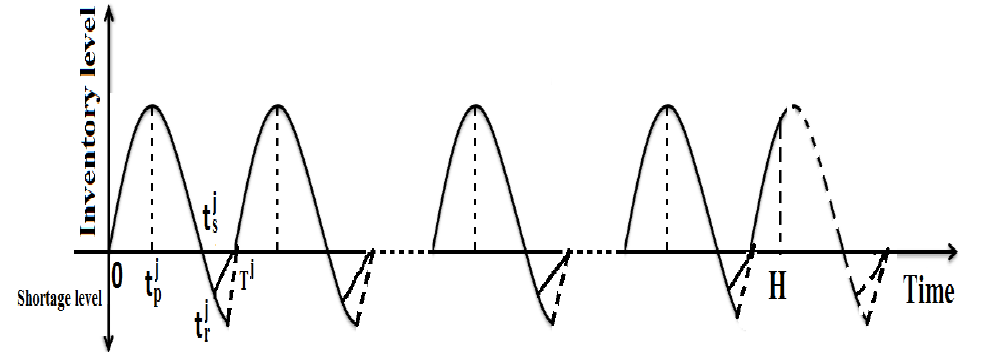
Figure 2. Graphical representation of the inventory model for